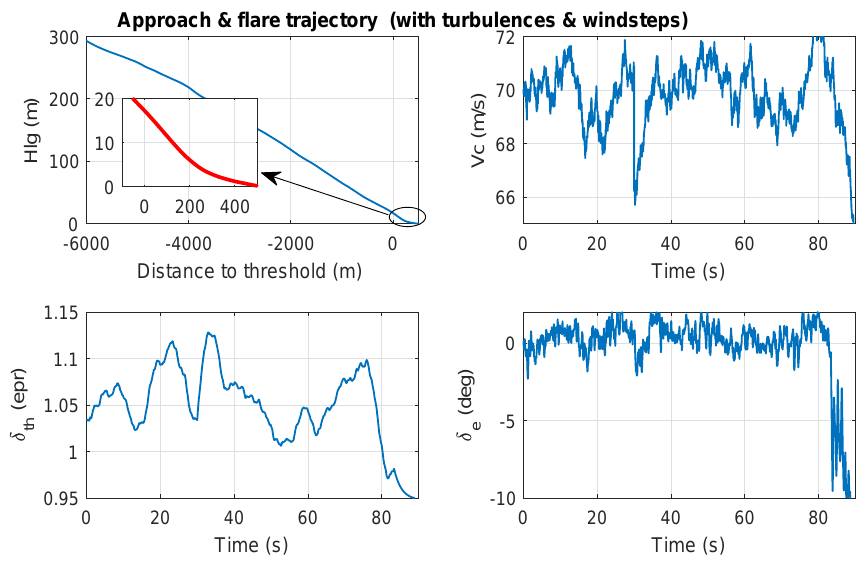
Figure 9. Final approach and flare trajectory with deterministic windsteps and turbulences.